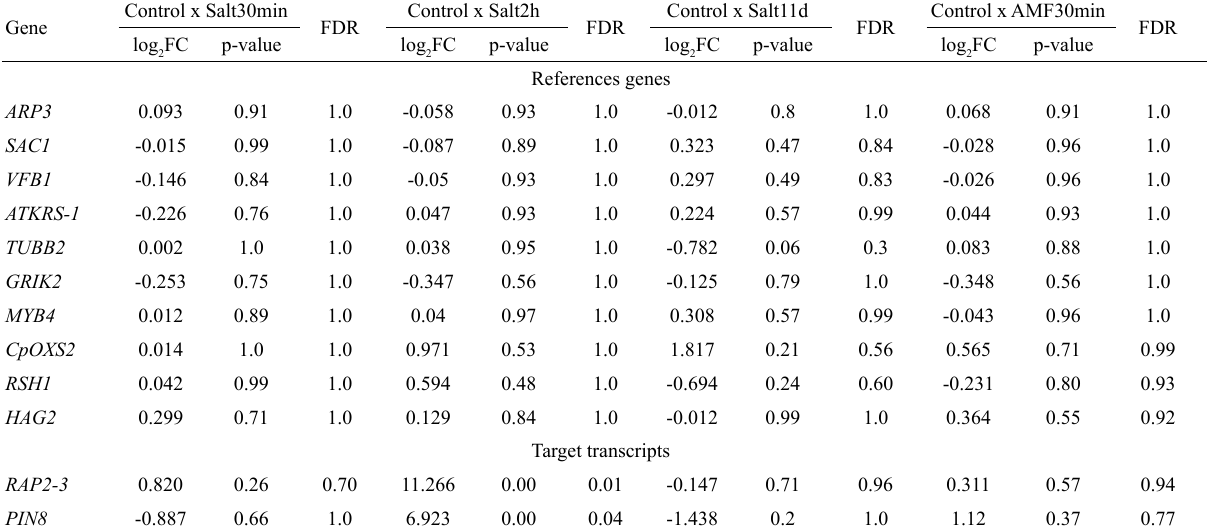
FC) and statistical analysis (p-value) of 10 reference genes and two target genes of root transcriptome of C. pyramidale Table 2 – Expression values (log 2 under salt stress and associated with arbuscular mycorrhizal fungi. Control x Gene